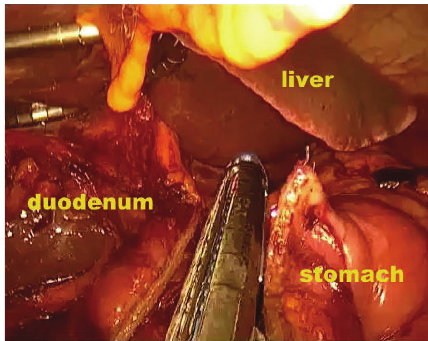
Figure 1: Transection of the duodenum 1-2cm distal to the pyloric ring.